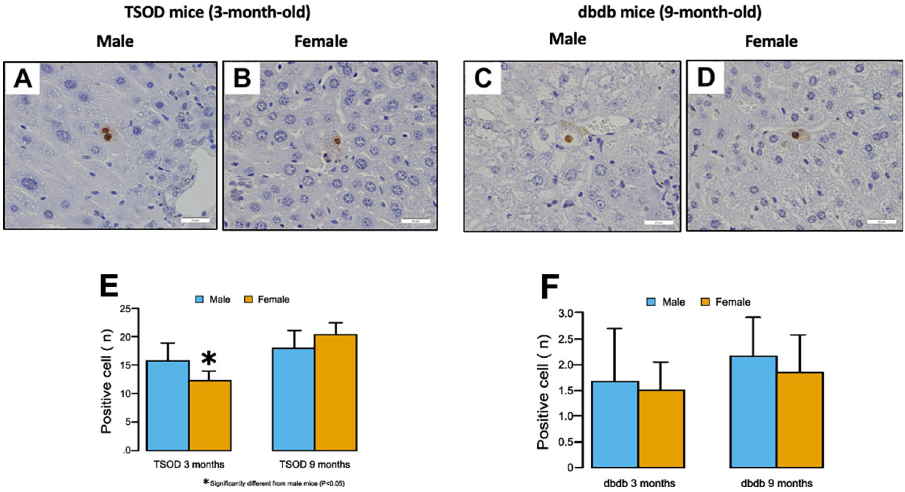
Fig 5. Terminal deoxynucleotidyl transferase dUTP nick end labeling (TUNEL) staining of liver tissues. A-D) Positively stained hepatocytes are observed in 3-month-old male (A) and female (B) TSOD mice and 9-month-old male (C) and female (D) db/db mice (original magnification × 400). E) The number of positively stained hepatocytes is significantly higher in 3-month-old male TSOD mice than in females (one-tailed t-test), but there is no significant sex difference in 9-month-old TSOD mice. F) For db/db mice, there is no significant sex difference in both age groups.